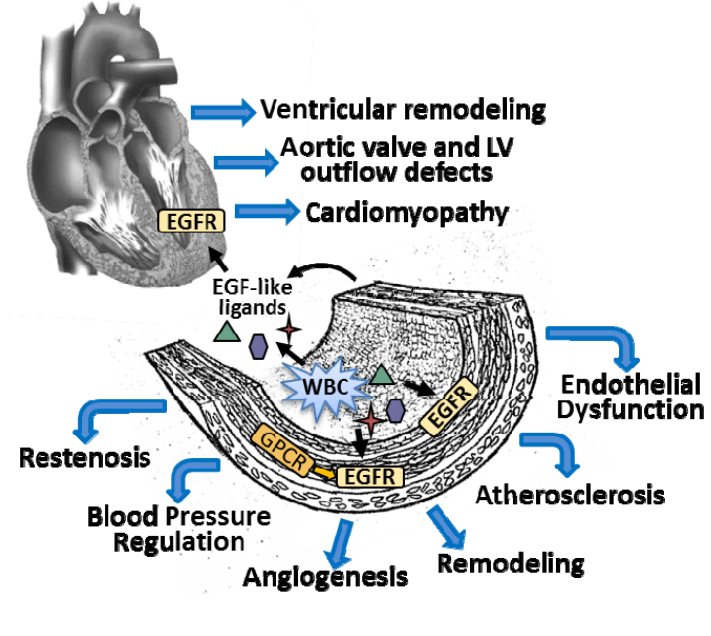
Figure 2. EGFR and its ligands are implicated in multiple vascular disease states.